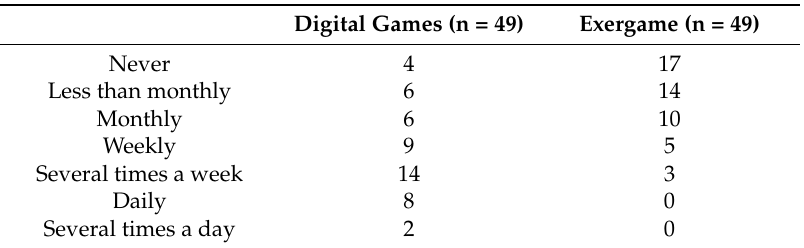
Table 4. Characteristics of the gameplay